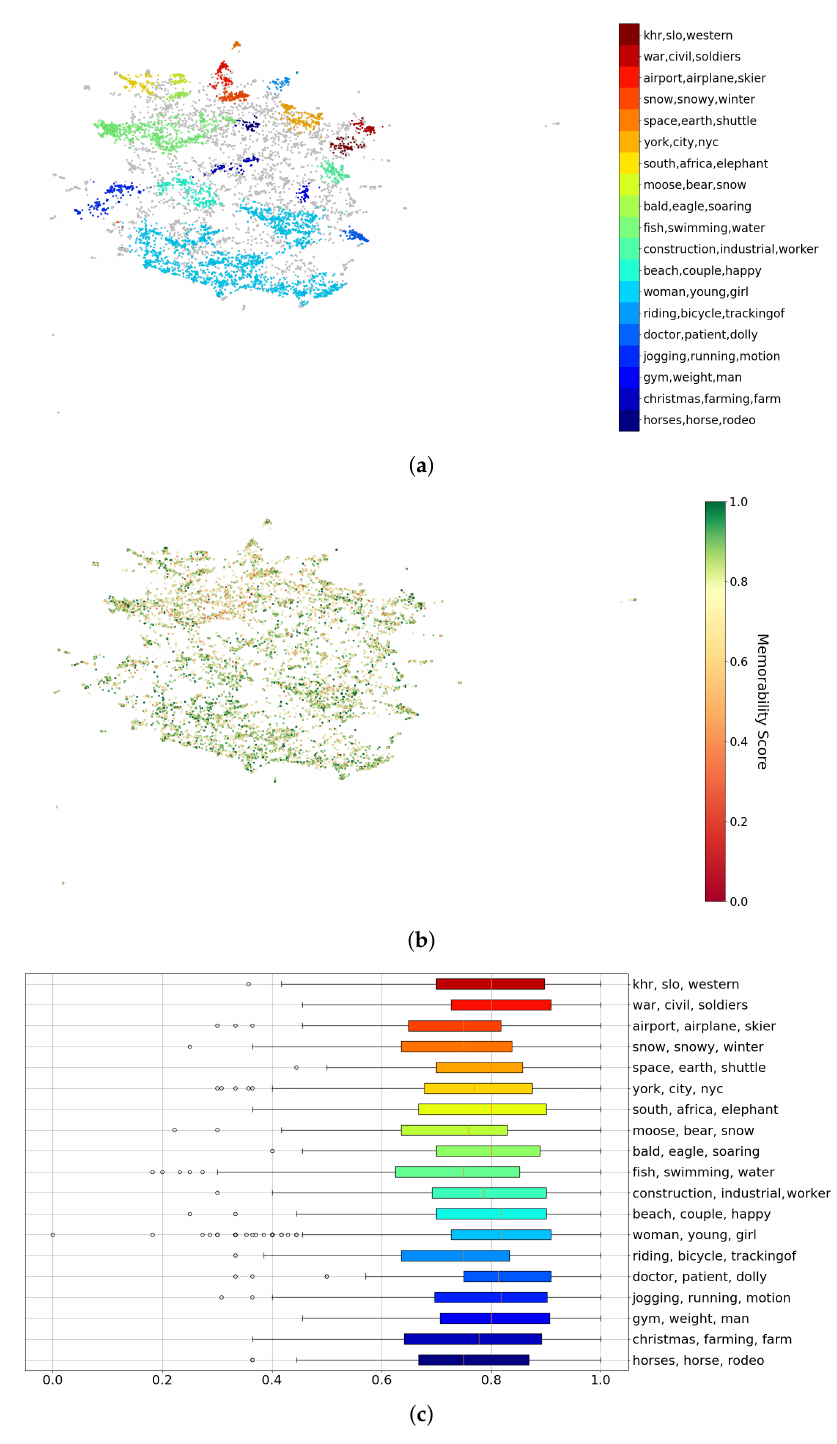
Figure 4. Automatic topic discovery from Sentence-BERT vector embeddings in the long-term memorability problem. Here the separability by topic is not particularly evident, perhaps due to the relatively low amount of annotations. ( a ) VideoMem’s topics. Each one is defined by each cluster’s top 3 most representative words. ( b ) Samples shown in color according to their memorability score. Again, low memorability regions can be spotted. ( c ) Distribution of memorability scores within each detected